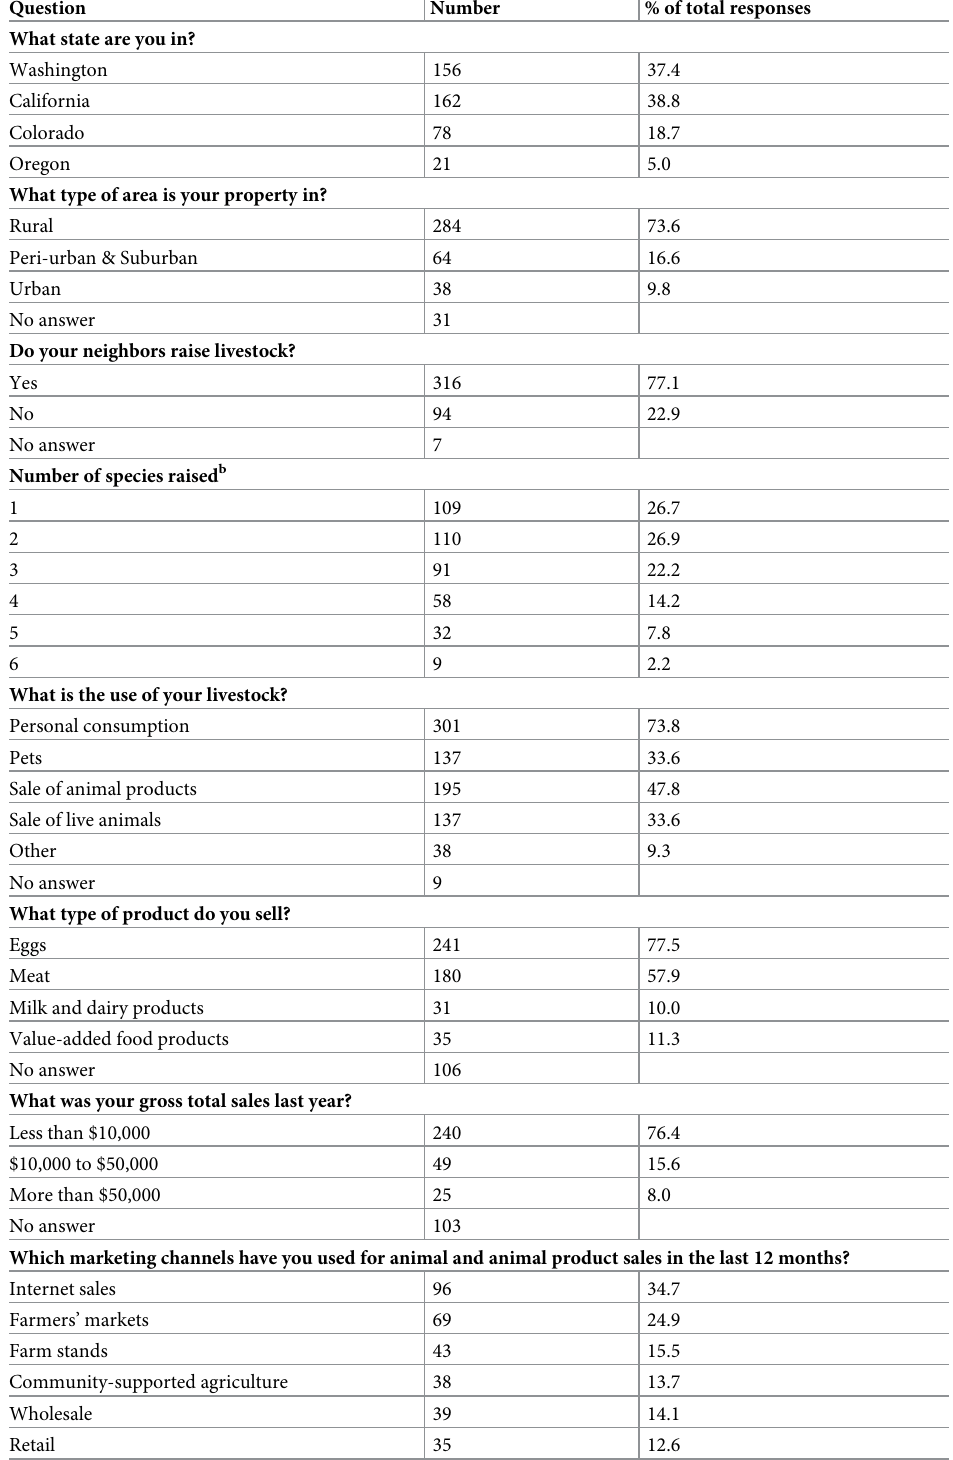
Table 1. General demographics of survey respondents (n = 417) on surveyed premises in 4 western states (Wash- ington, California, Colorado and Oregon) a